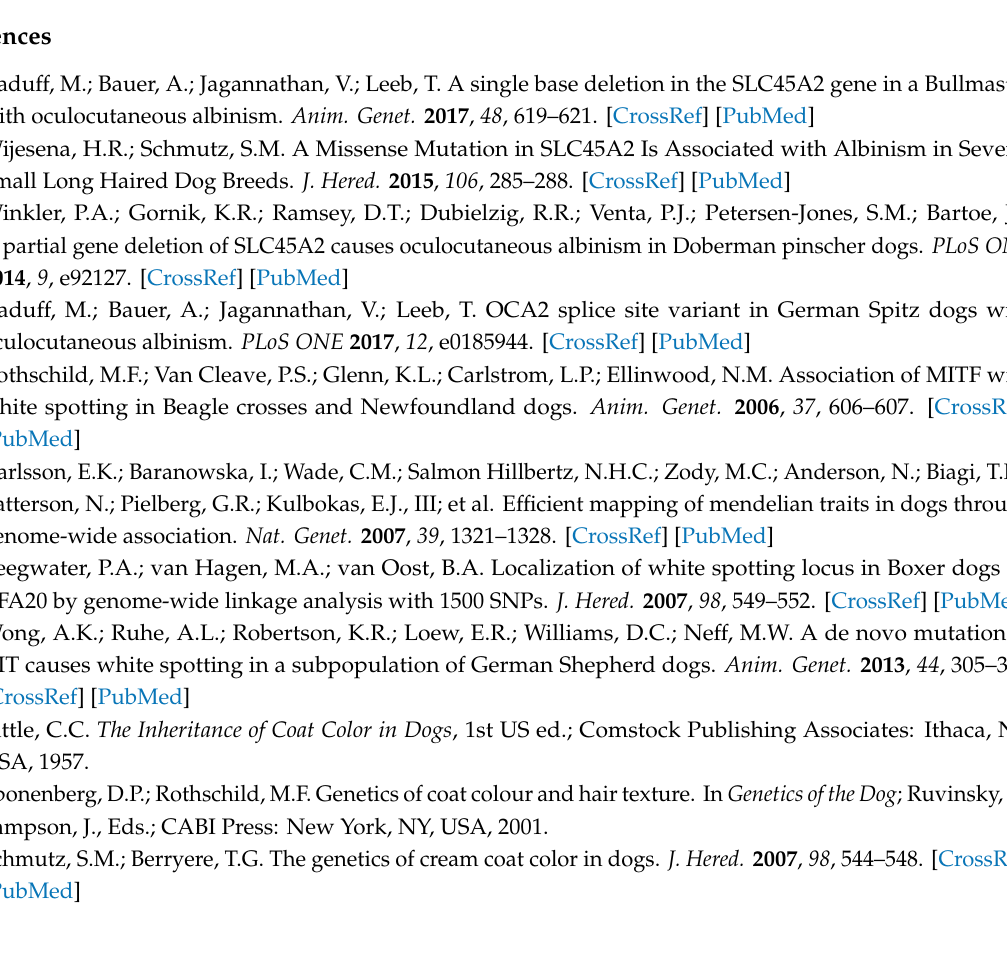
Figure S1: RT-qPCR experiments on MFSD12 according to Chr20:55850145 genotype, Table S1: Primers used in this study for qPCR experiments and variant sequencing, Table S2: Dogs breeds selected for the GWAS, File S1: The sequence of the gap at